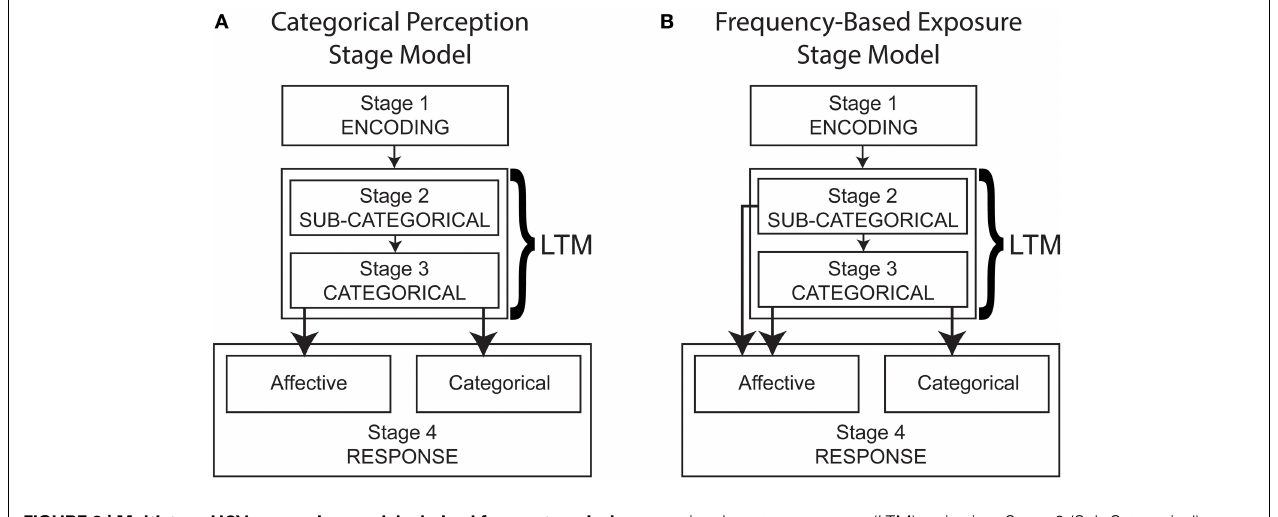
FIGURE 2 | Multistage UCV processing models derived from categorical perception (A) and frequency-based exposure accounts (B). Stage 1 (Encoding) relies on immediate memory whereas Stage 3 (Categorical)